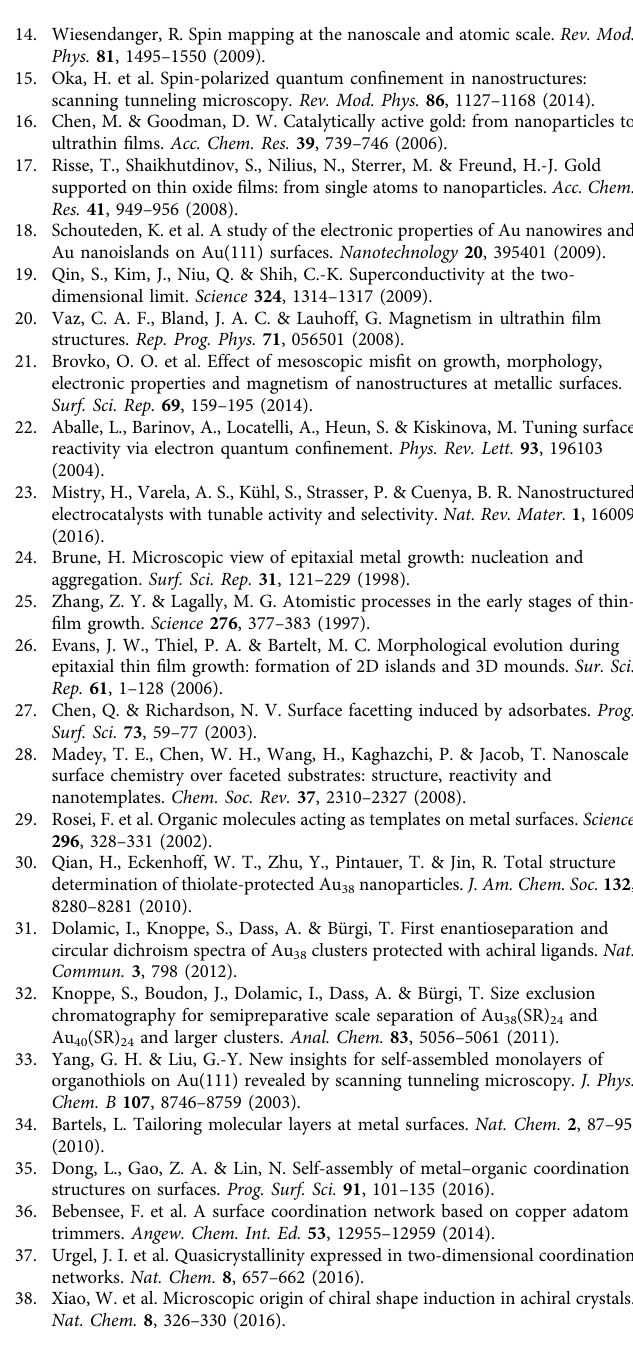
Fig. 7 Dynamics. a – d Successive STM images (15 × 15 nm 2 , I set = 100 pA, V bias = − 900 mV) at the same location showing the growth and decay of an adatom island, along with the adsorption and desorption